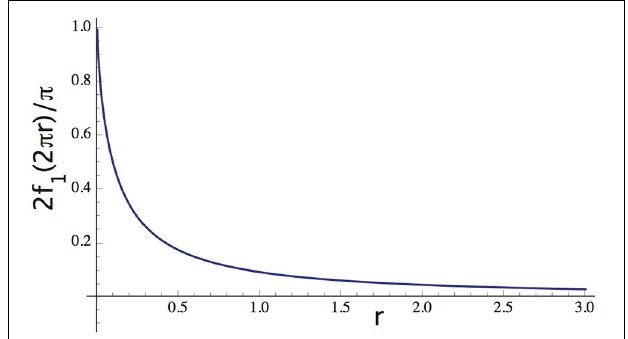
FIGURE 3 | The normalized value of f 1 , showing that it decays